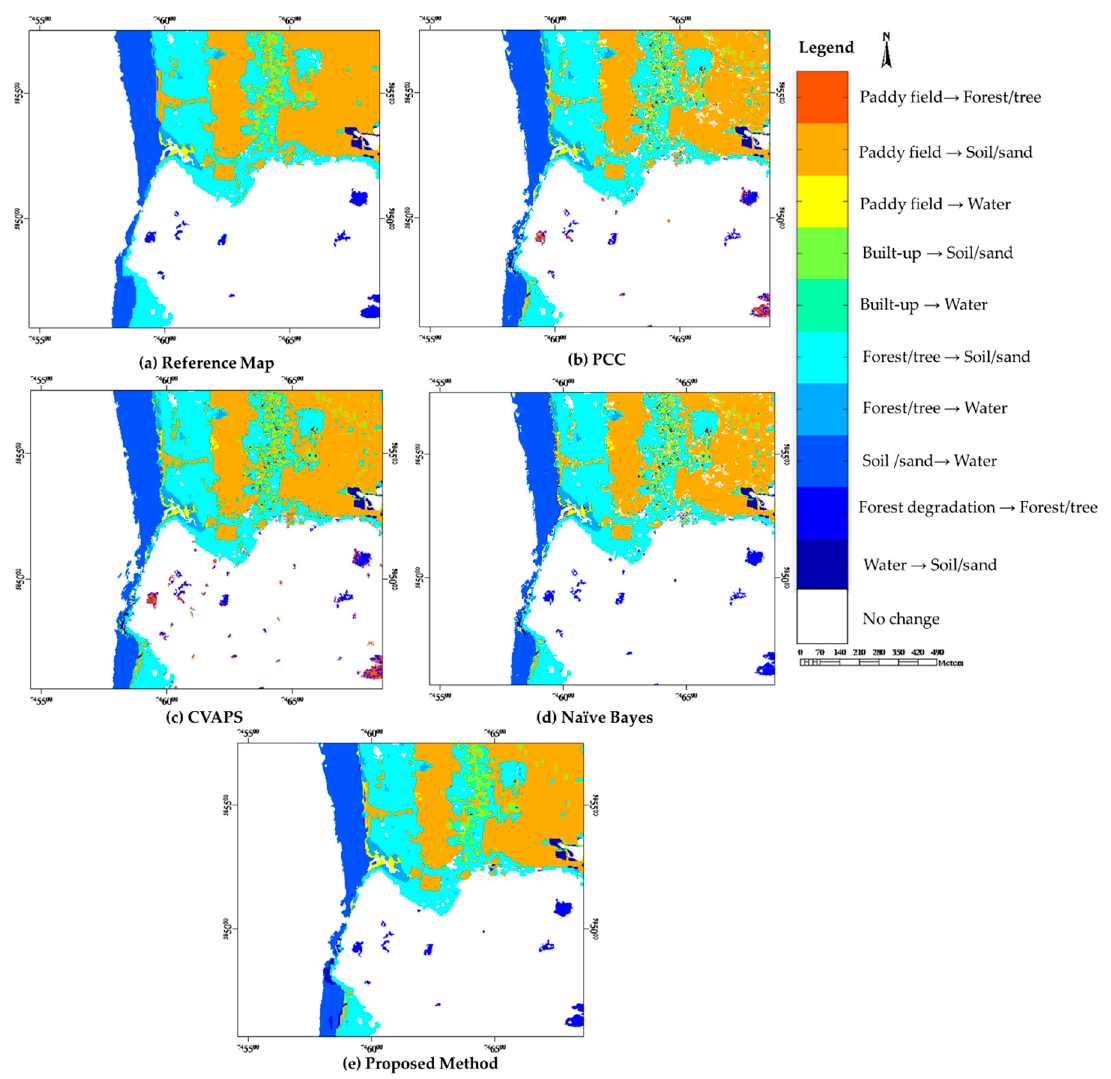
Figure 10. LULC type-of-change maps obtained from the Experiment II data set.